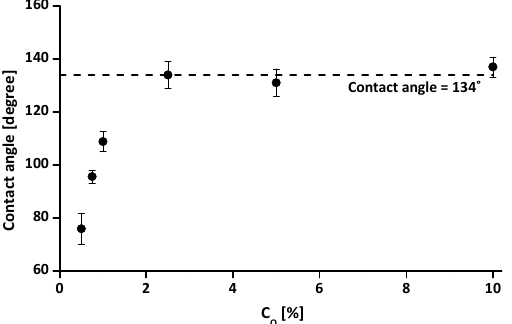
Figure 5. The measured soil-water contact angles with different treatment concentrations (C O ). Note that the error bars in the figure indicate standard deviations of measured values from 10 water droplets.